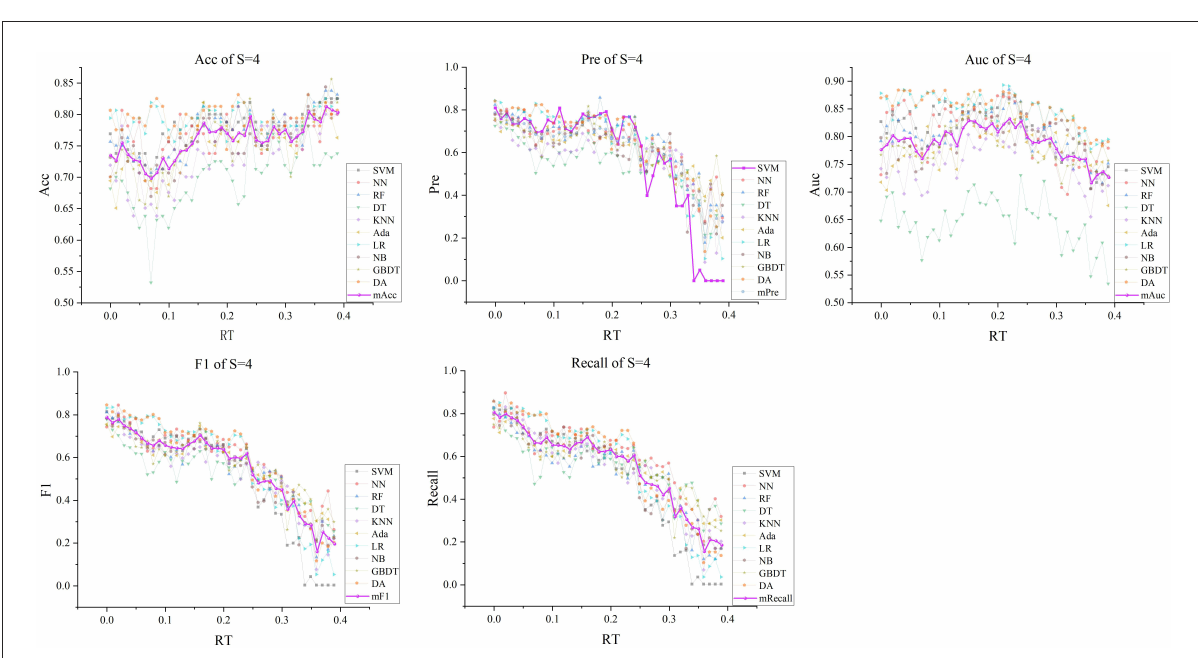
FIGURE7 The five indexes of F ′ RT_S with S = 4 on the ten models, wherein the dark purple lines represent the mean indexes (mAcc, mPre, mAuc, mF1, mRecall), and the other colors represent the performance of the ten models.